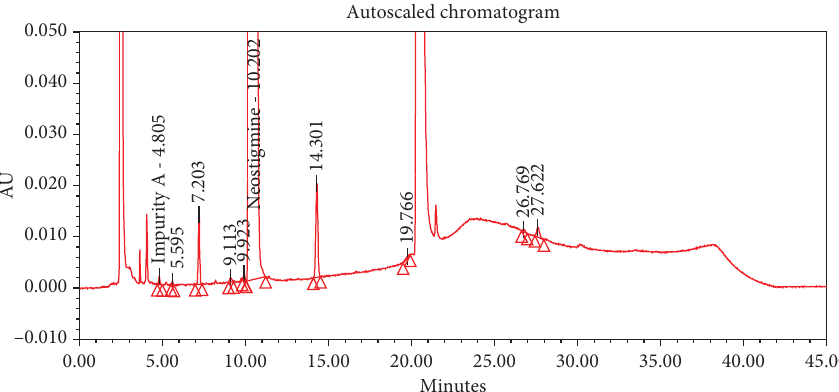
Figure 13: Chromatogram of oxidative hydrolysis of NMS injection formulation (1mL of 30% H